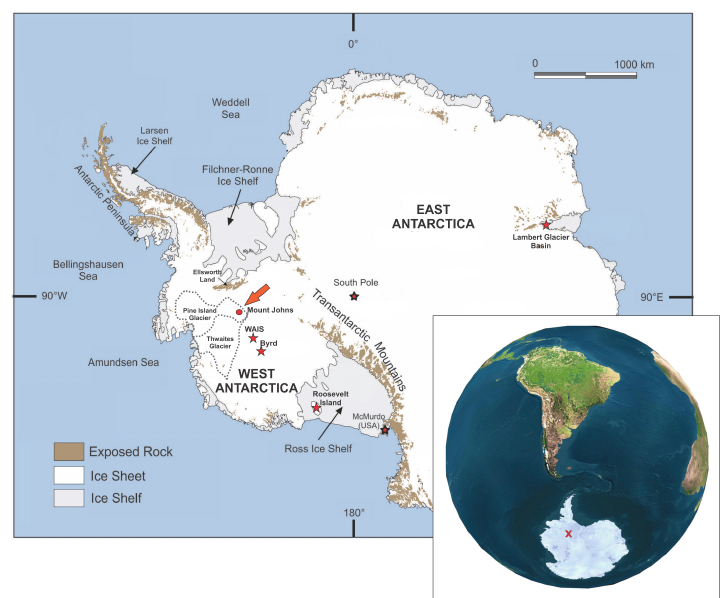
Figure 1. Map of Antarctica showing the site of the MJ ice core site (red arrow) and locations of sites discussed in the text (figure adapted from the U.S. Geological Survey,